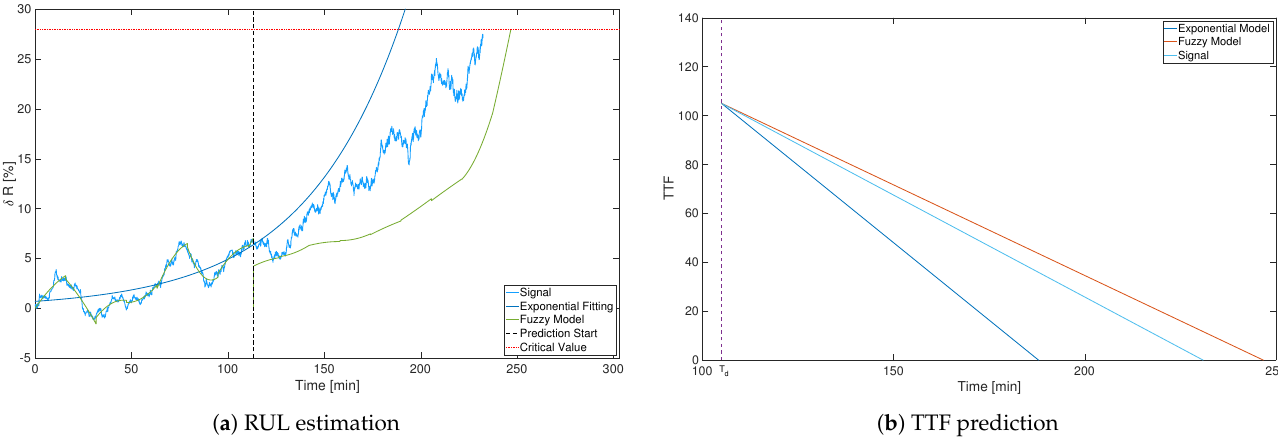
Figure 17. RUL and TTF analysis of the 23th MOSFET after 45% of its real lifetime.